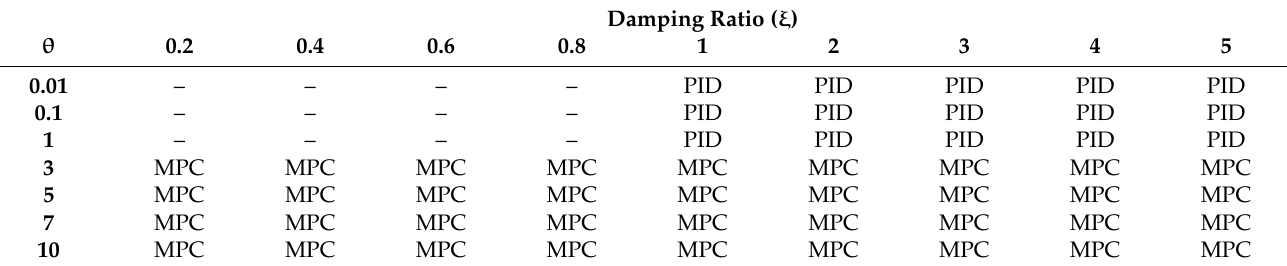
Table 15. Preferred controller for second order